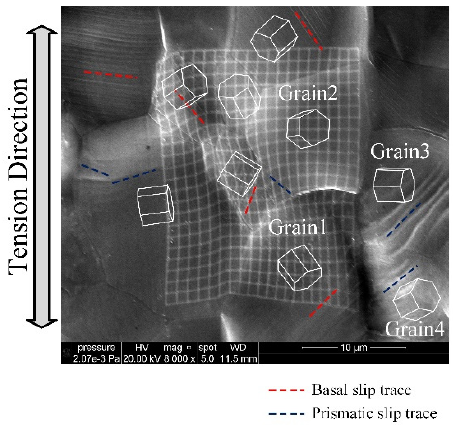
Figure 3. Microstructure after 0.15 tension strain.